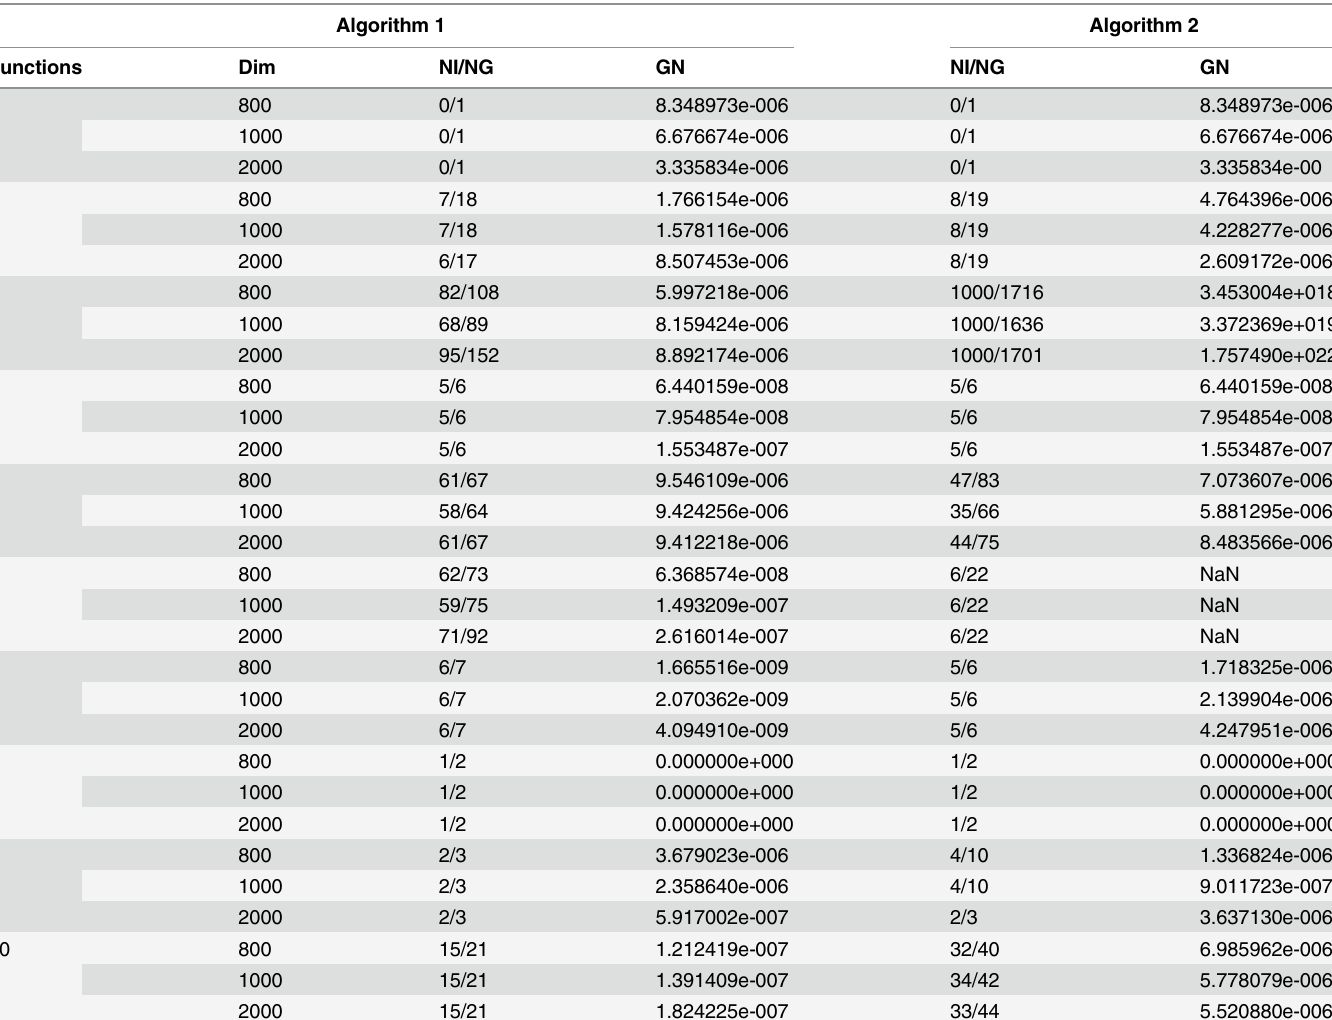
Table 1. Numerical results using Algorithms 1 and